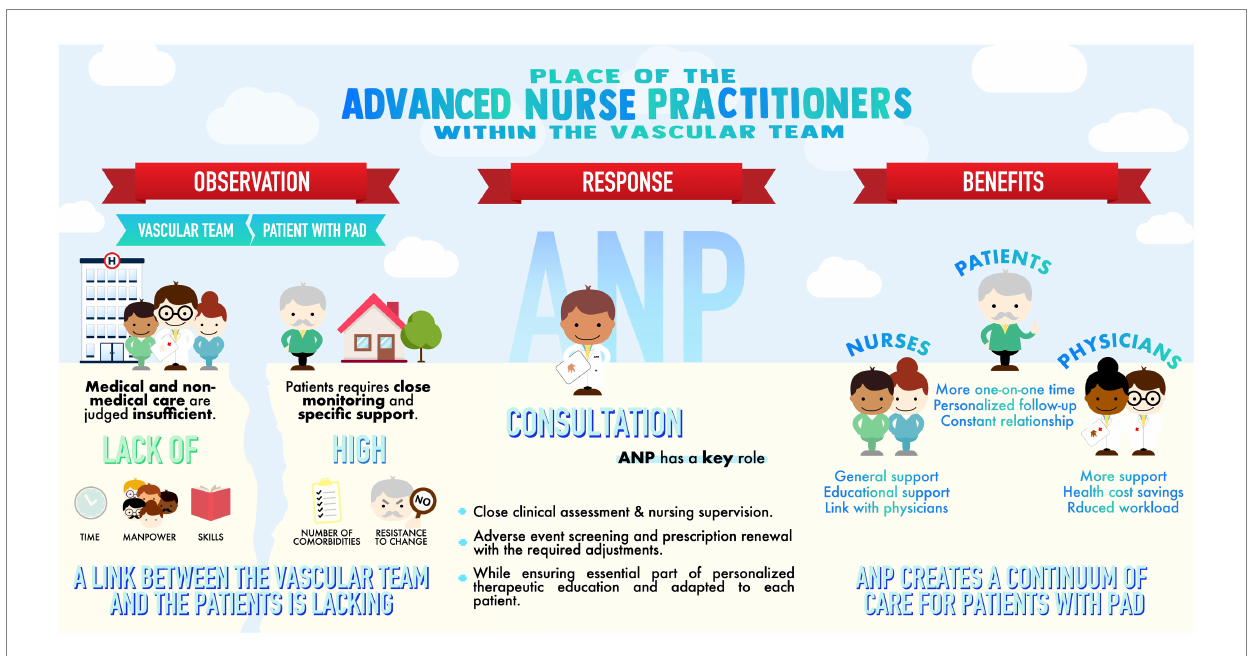
FIGURE 2 Features emerged from participants’ responses: the specific needs of vascular medicine in relation to the patients’ profiles, the place of an Advanced Nurse Practitionner (ANP) in the vascular team, and the expected benefits.